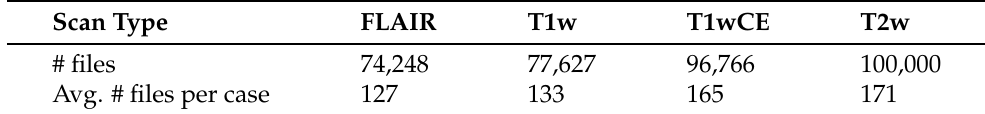
Figure 2. A sequence of FLAIR scans for patient 10 in the dataset. Table 2. Number of files for each scan